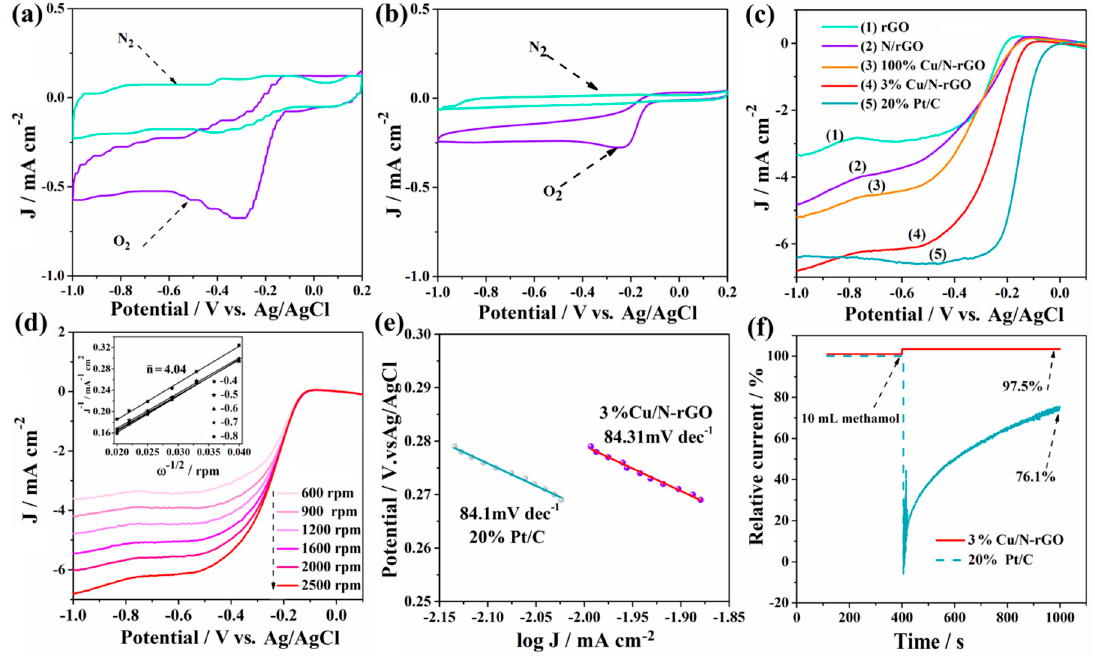
Figure 7. Cyclic voltammetry (CV) curves of ( a ) 3%Cu/N − rGO and ( b ) N-rGO in N 2 -saturated and O 2 -saturated in 0.1 M KOH. ( c ) Linear sweep voltammetry (LSV) curves of the rotating electrodes of rGO, N/rGO 3%Cu/N-rGO, 100%Cu/N-rGO, and 20% Pt/C at 2500 rpm. ( d ) LSV curves of 3%Cu/N-rGO at different rotating rates (inset: corresponding Koutecky–Levich plots). ( e ) Tafel plots of 3%Cu/N-rGO and commercial 20 wt% Pt/C in O 2 -saturated 0.1 M KOH at a scan rate of 10 mV·s − 1 . ( f ) Current − time (I–t) curves of Cu − N/C and Pt/C at 0.55 V in 0.1 M KOH after addition of 10 mL methanol.